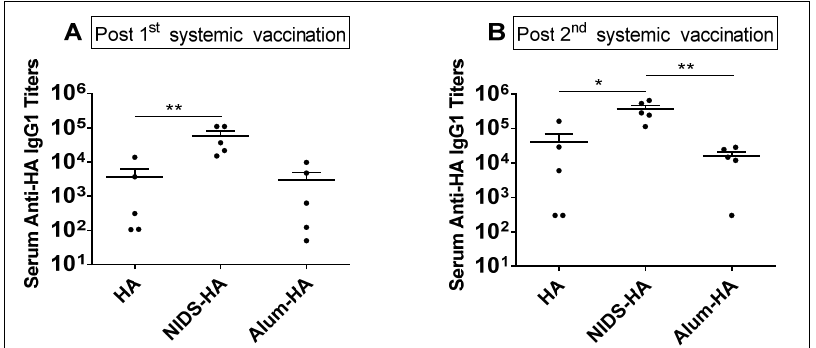
Figure 8. Adjuvant effect of NIDS in the outbred CD1 mice on serum antigen specific antibody responses following IM vaccinations. ( A ) Anti ‐ HA IgG1 antibody titers in sera collected at 3 weeks following a single IM vaccination; ( B ) Anti ‐ HA IgG1 antibody titers in sera collected at 10 days post